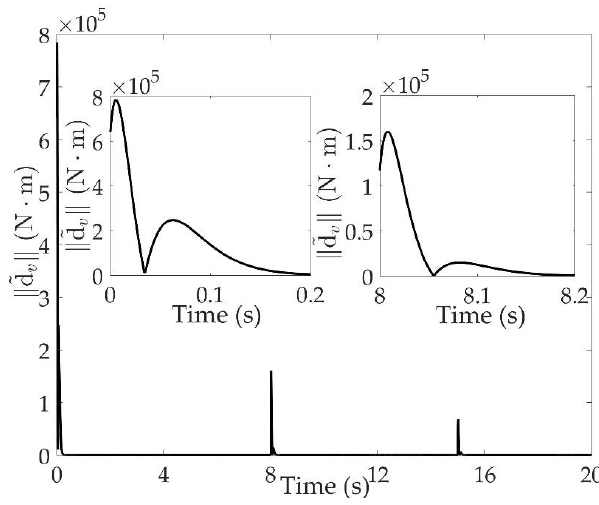
Figure 12. Estimation error of total disturbances (cid:107) (cid:101) d v (cid:107)